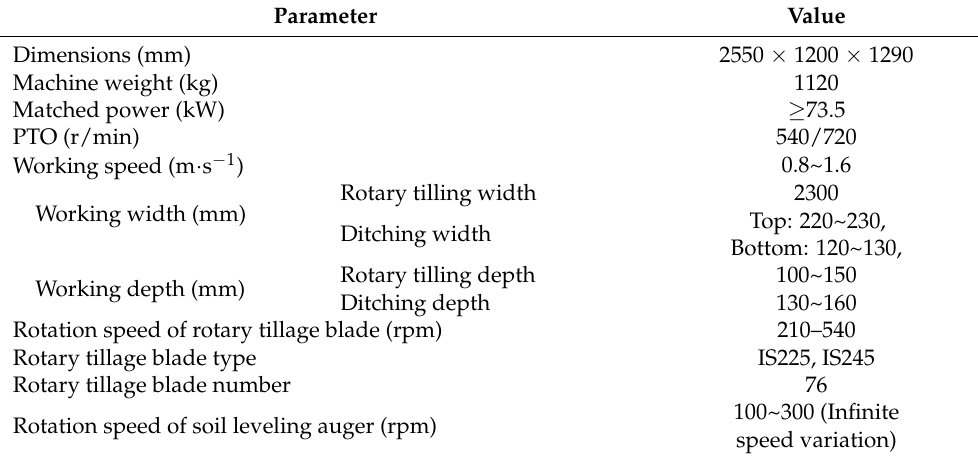
Table 1. Main technical parameters of seedbed preparation machine for rapeseed combined